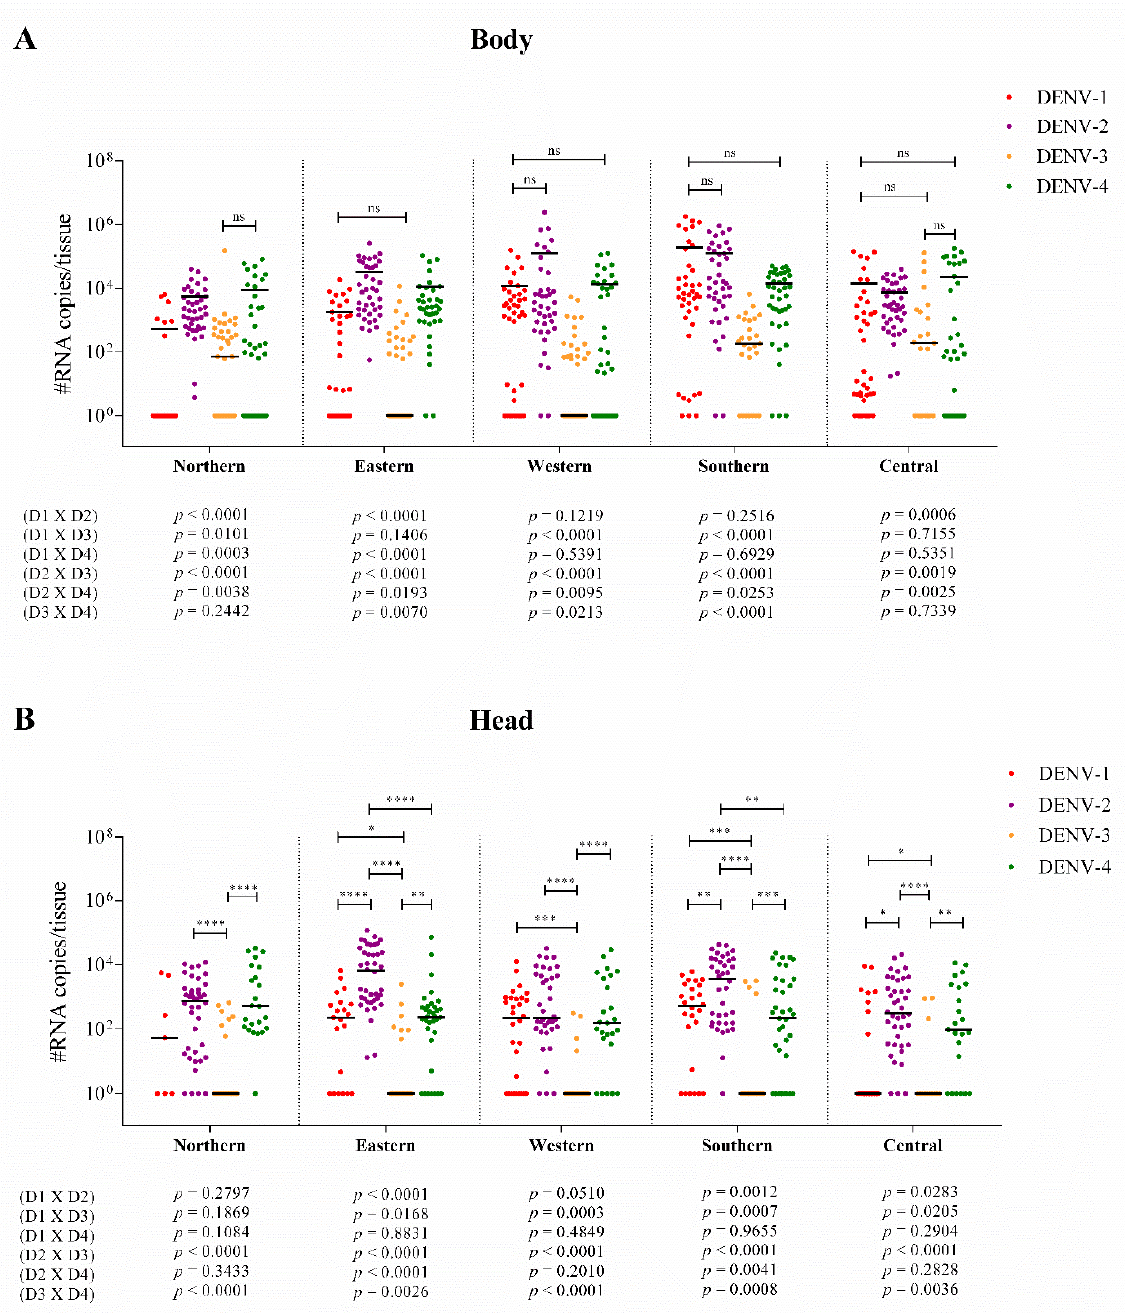
Figure 6. Inter-serotype variability of the patterns of body ( A ) and head/SG ( B ) viral loads for DENV serotypes 1–4 (different colored symbols) in each of the five Ae. aegypti populations. Each bar in the figures represents a median viral load in the data. In ( A ), we represent only the non-significant results (more results were statistically distinct) to simplify the demonstration and facilitate comparisons. In ( B ), only the significant results are represented. All p values are listed for the six possible comparisons among the DENV serotypes to each population. D1 = DENV-1; D2 = DENV-2; D3 = DENV-3; D4 = DENV-4. p values > 0.05 (non-significant) are represented as “ns”. p values ≤ 0.05, ≤ 0.01, ≤ 0.001, and ≤ 0.0001 are summarized with one (*), two (**), three (***), and four (****) asterisks, respectively.